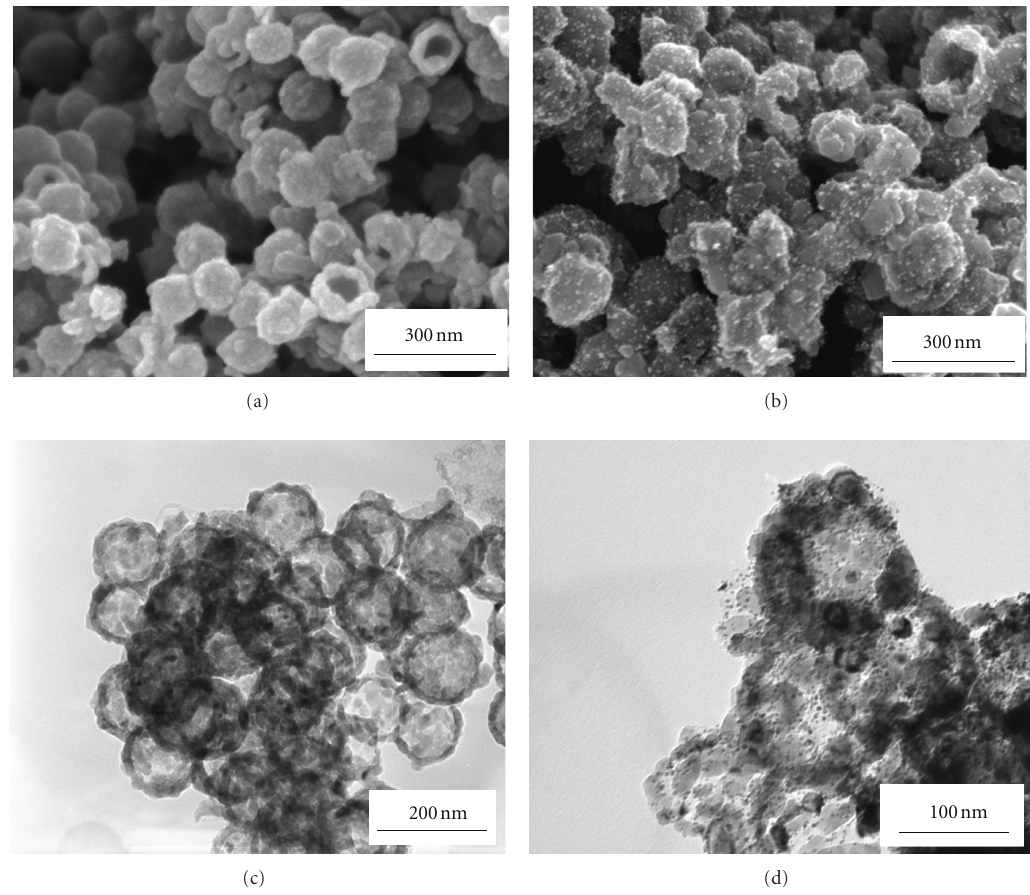
Figure 1: SEM (a) and TEM (c) images pristine hollow Nb-TiO 2 nanostructures. SEM (b) and TEM (d) images Pt nanoparticles deposited on hollow Nb-TiO 2